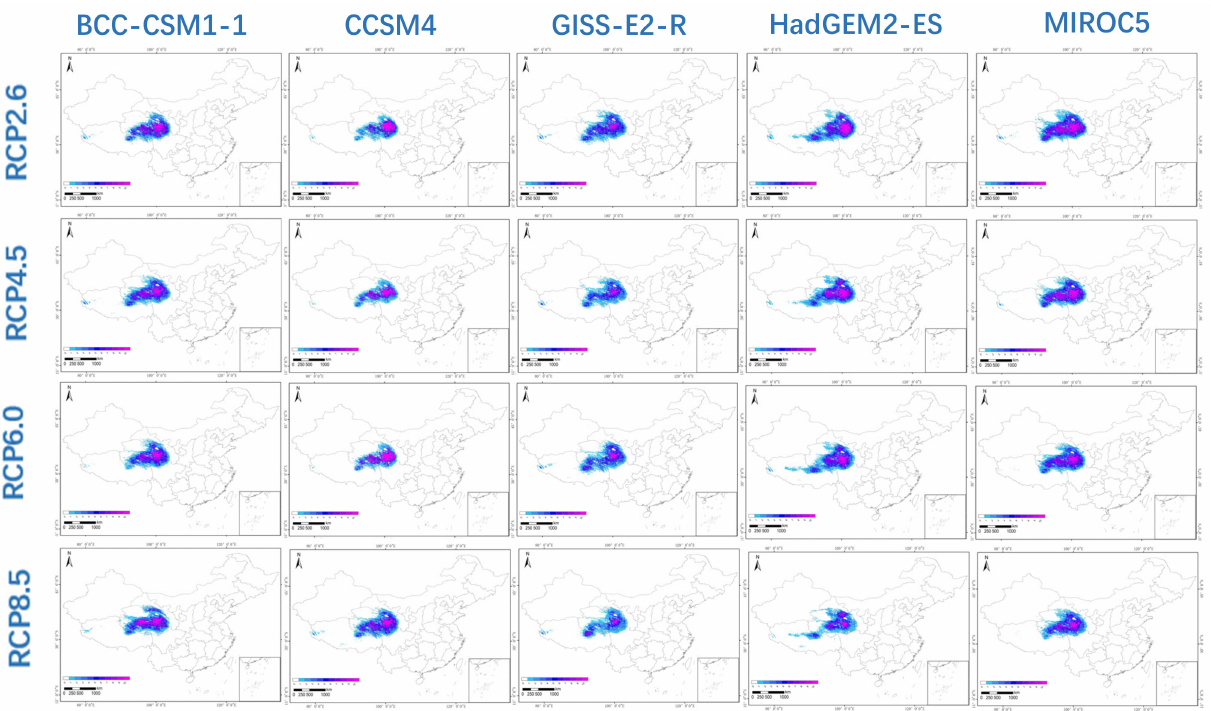
Figure 4. The habitat suitability of Pomatosace filicula population under four climate scenarios (RCP 2.6, RCP 4.5, RCP 6.0 and RCP 8.5) and five General Circulation models (BCC-CSM1-1, CCSM4, GIS-E2-R, HadGEM2-ES and MIROC5) in 2070.